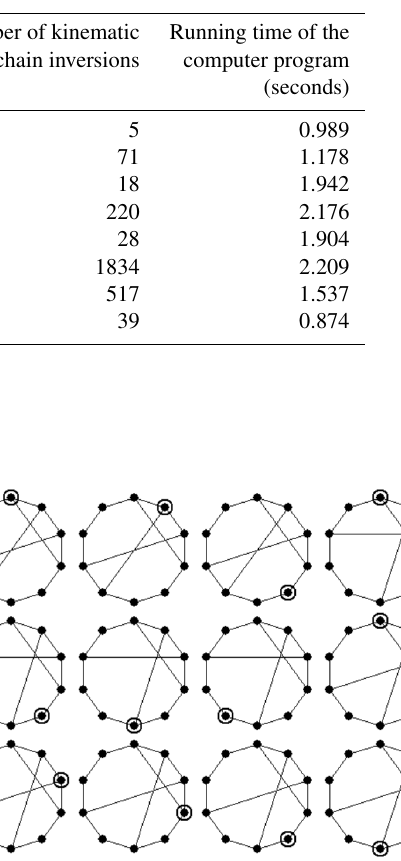
Figure 8. A part of the 10-link 1-DOF kinematic chain inversions.